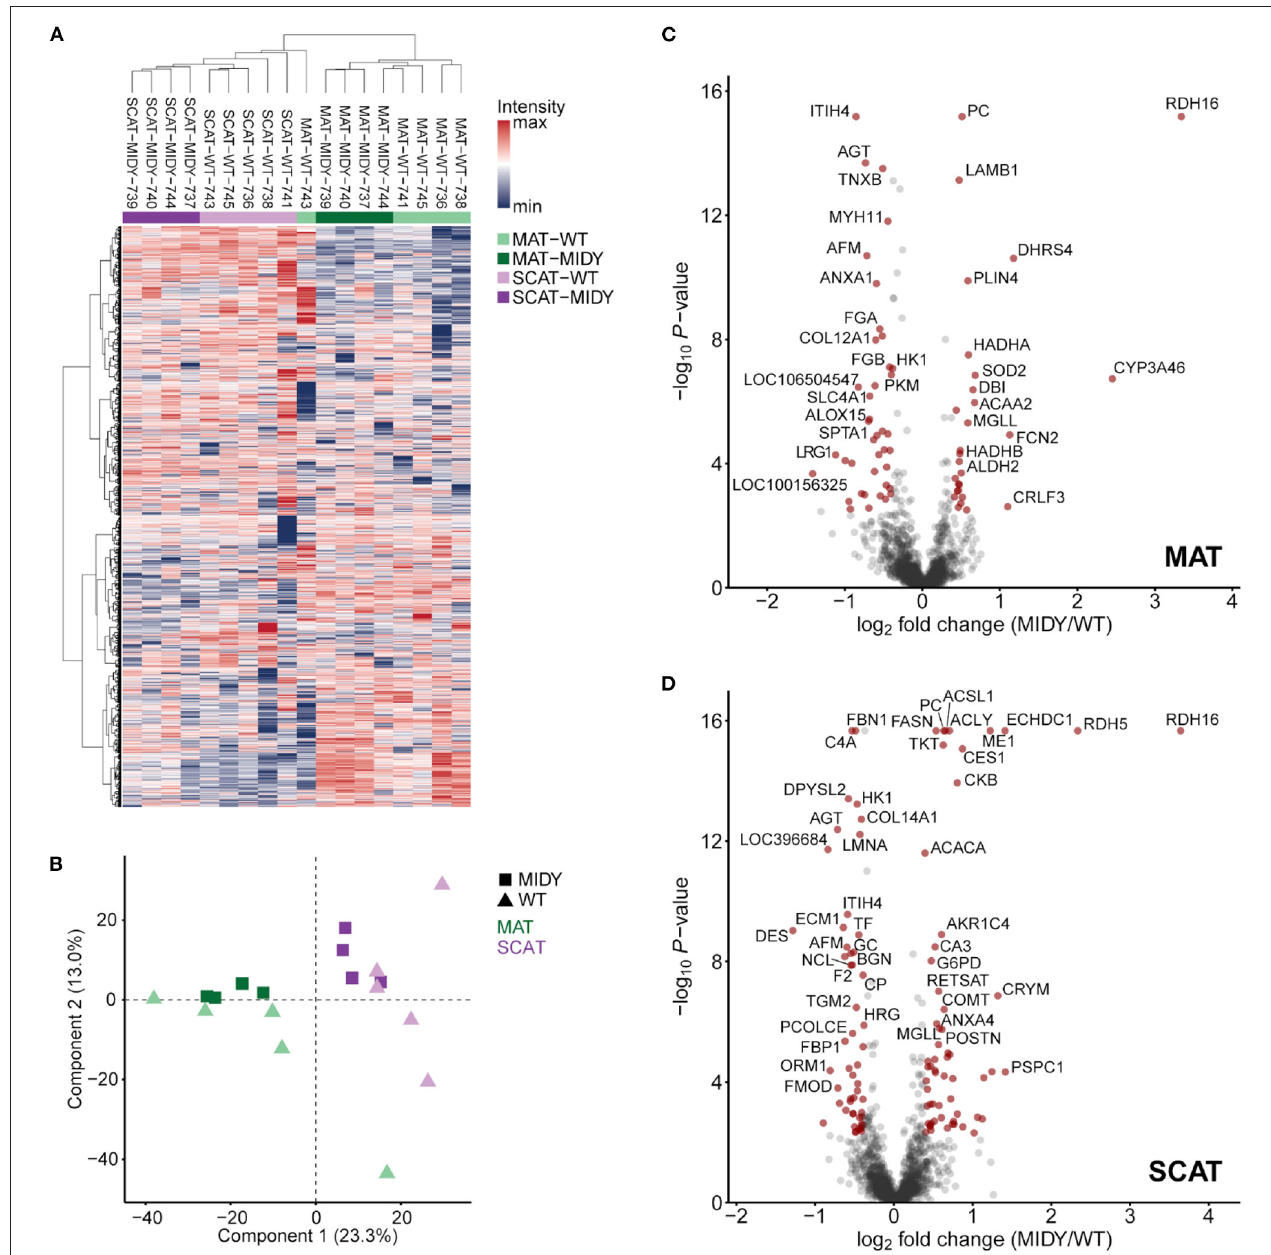
FIGURE 1 | Quantitative proteome analysis of mesenteric (MAT) and subcutaneous (SCAT) adipose tissue from MIDY and WT pigs. (A) Unsupervised hierarchical clustering of normalized protein intensities of MAT and SCAT from MIDY ( n = 4) and WT ( n = 5) animals. The color code indicates normalized intensity values. (B) Principal component analysis (PCA) indicates clustering of individual sample groups. Spots represent individual animals. Green and purple colors indicate MAT and SCAT samples, and squares and triangles indicate MIDY and WT samples, respectively. (C,D) Volcano plots visualize the quantitative proteome alterations in MAT (C) and SCAT (D) from MIDY vs. WT pigs. Red spots indicate differentially abundant proteins (fold-change > 1.3 and Benjamini-Hochberg-adjusted P -value < 0.05).